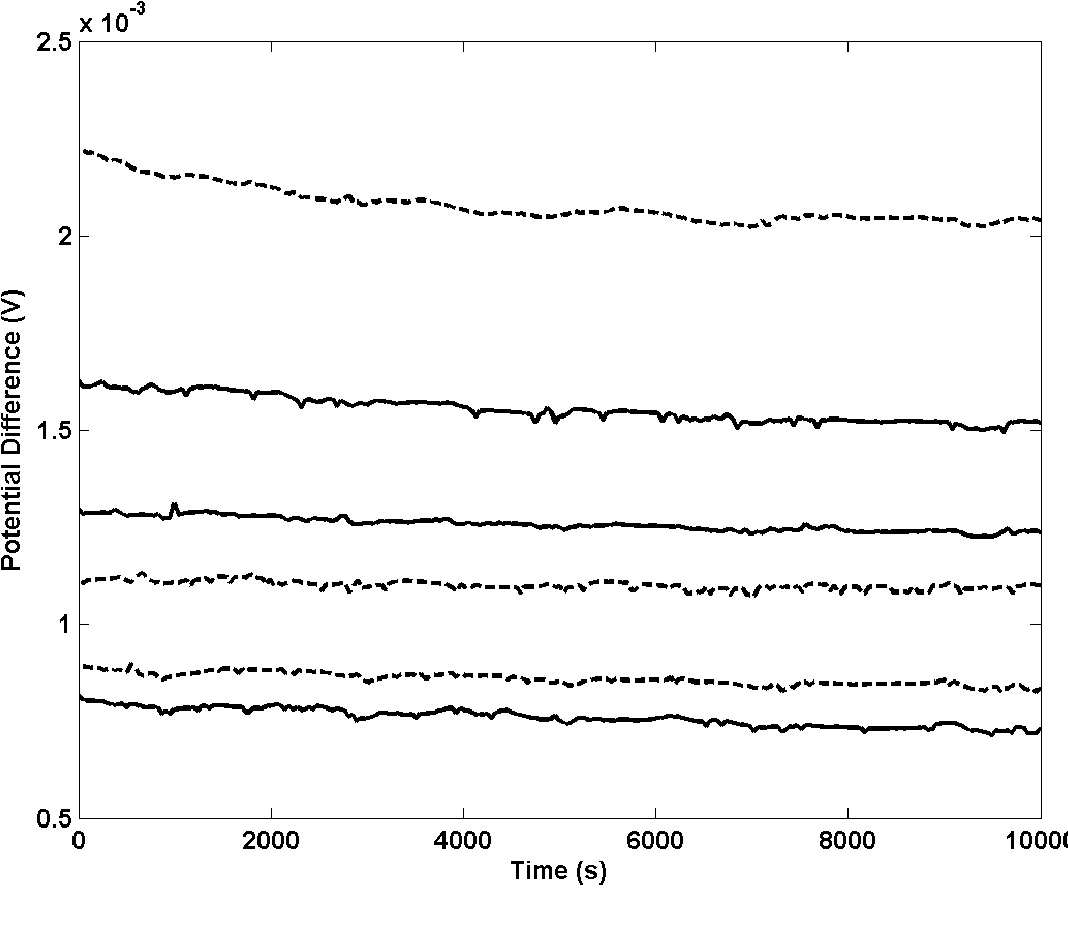
Figure 2. Transient potential difference measurements for electrolytic Ag/AgCl electrodes equilibrated in a 0.01 M HCl solution vs. a thermal electrolytic defacto reference electrode. Each profile corresponds to an individual electrode. Electrodes were prepared using Ag wire that had no pretreatment (solid lines) and a bending process whereby the material was flexed ten times along the 0.5 cm length (dashed